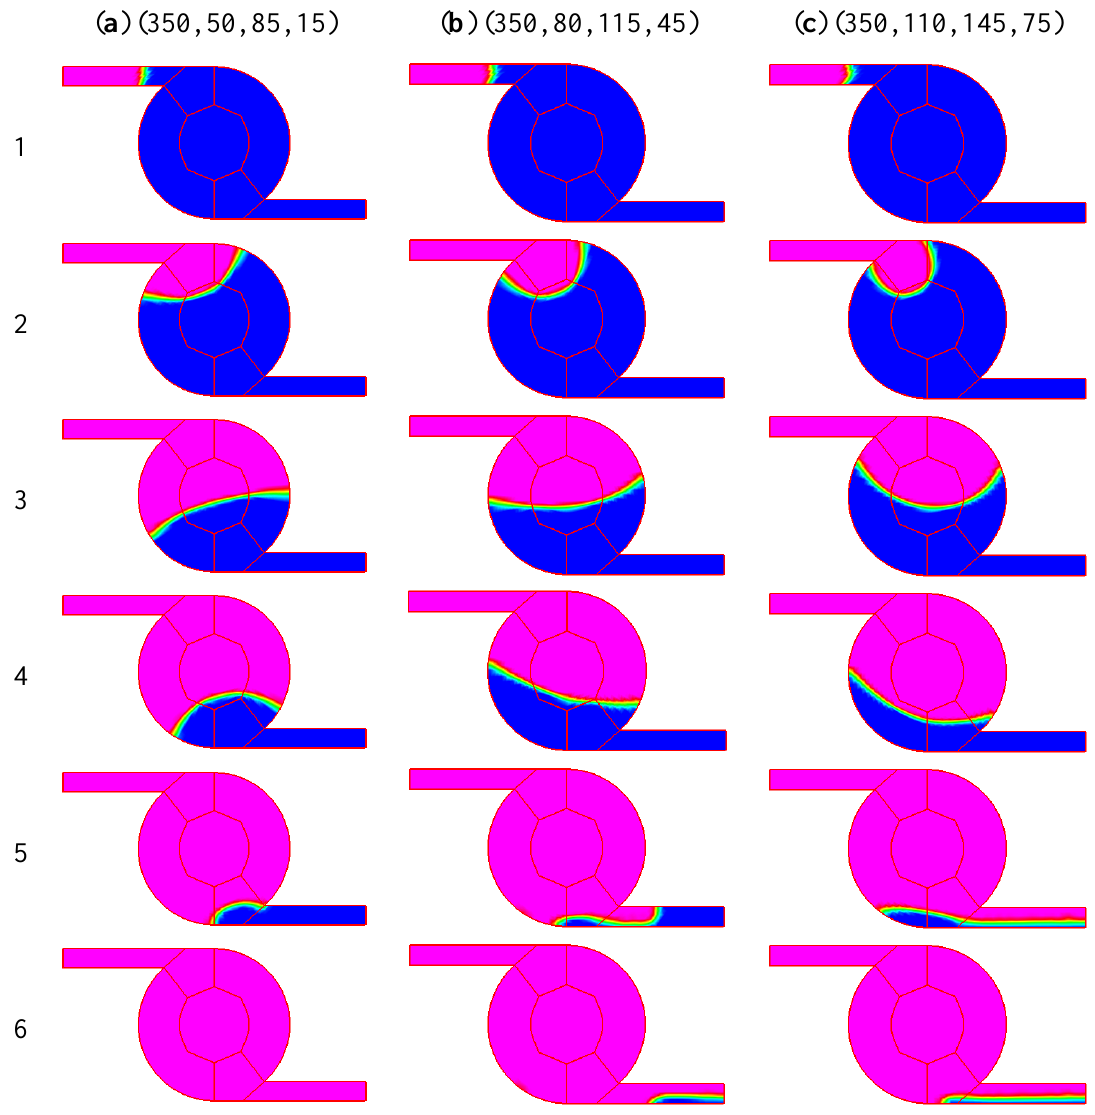
Figure 9. Filling process for various θ θ is 85°; ( b ) K is 350° s/m, θ uc 110°, θ is 75° and θ lc